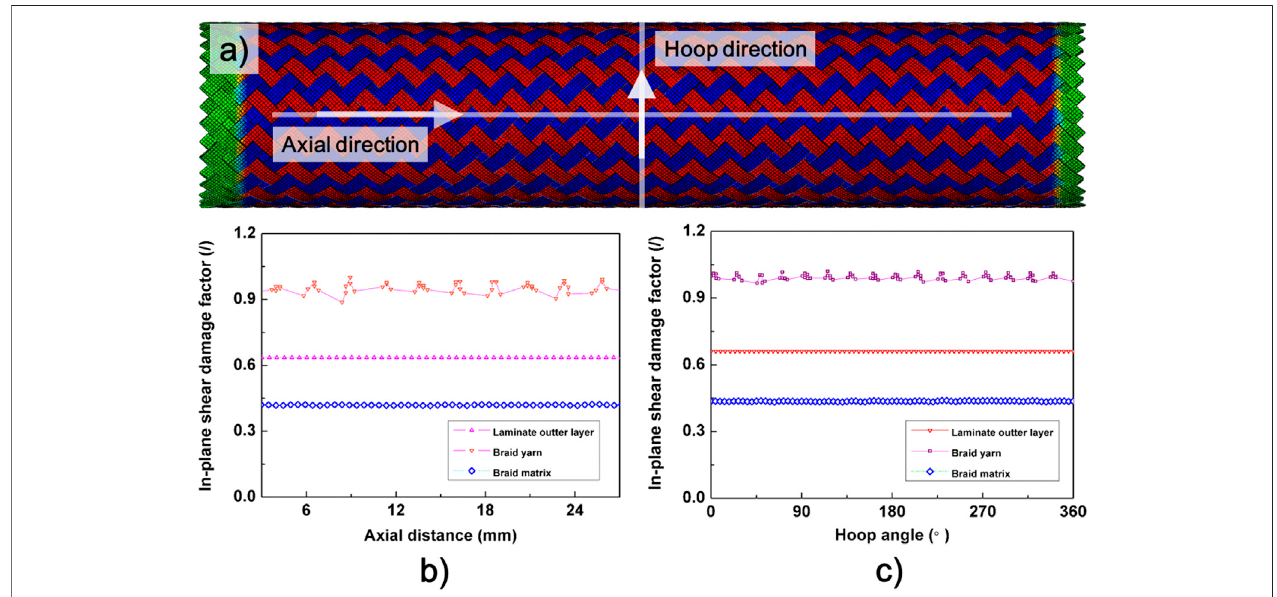
FIGURE10| Thelocalsheardamagefactoranalysisofthetubeundertheglobaltensileloadings. (A) Theuniformshearlocalstressjustbeforesheardamageofthe yarn; (B) the in-plane damagefactors ofthe braided tube yarn,braidedtube matrix,and laminated tube outside on theaxial direction; (C) thein-planedamage factors of the braided tube yarn, braided tube matrix, and laminated tube on the hoop direction.